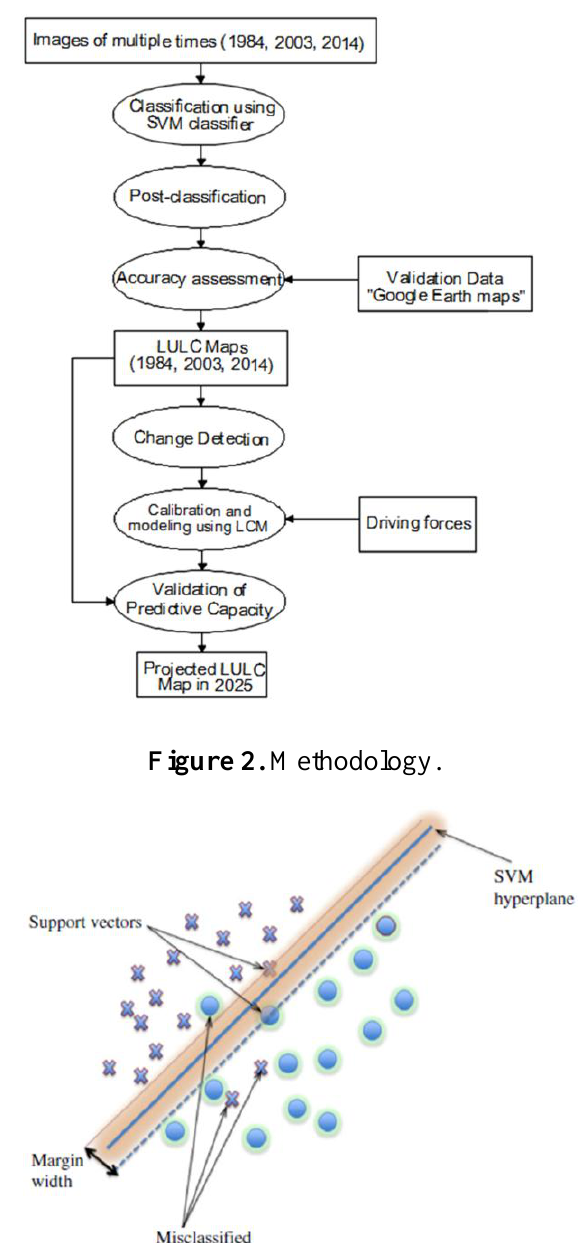
Figure 3. Linear support vector machine